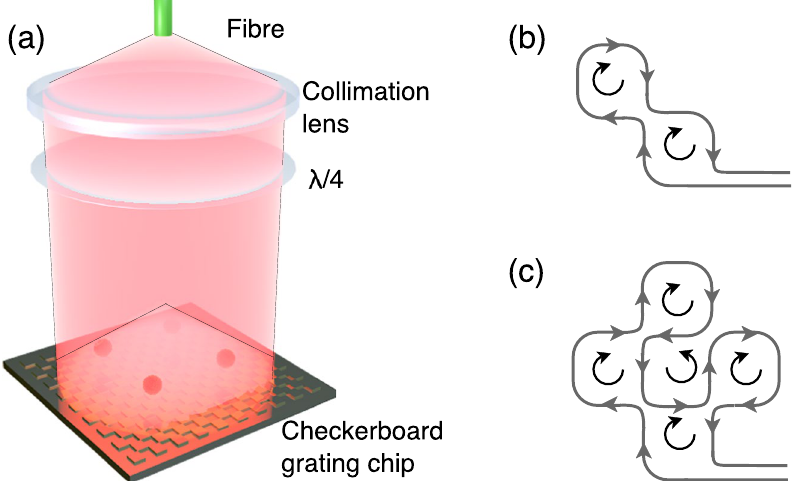
Figure 5. ( a ) Schematic of checkerboard grating. Linearly polarised light diverges from the optical fibre, is collimated and circularly polarised. ( b )/( c ) Wire pattern for creation of two/four magnetic minima. Grey lines indicate the wire and black curves emphasize the direction of current